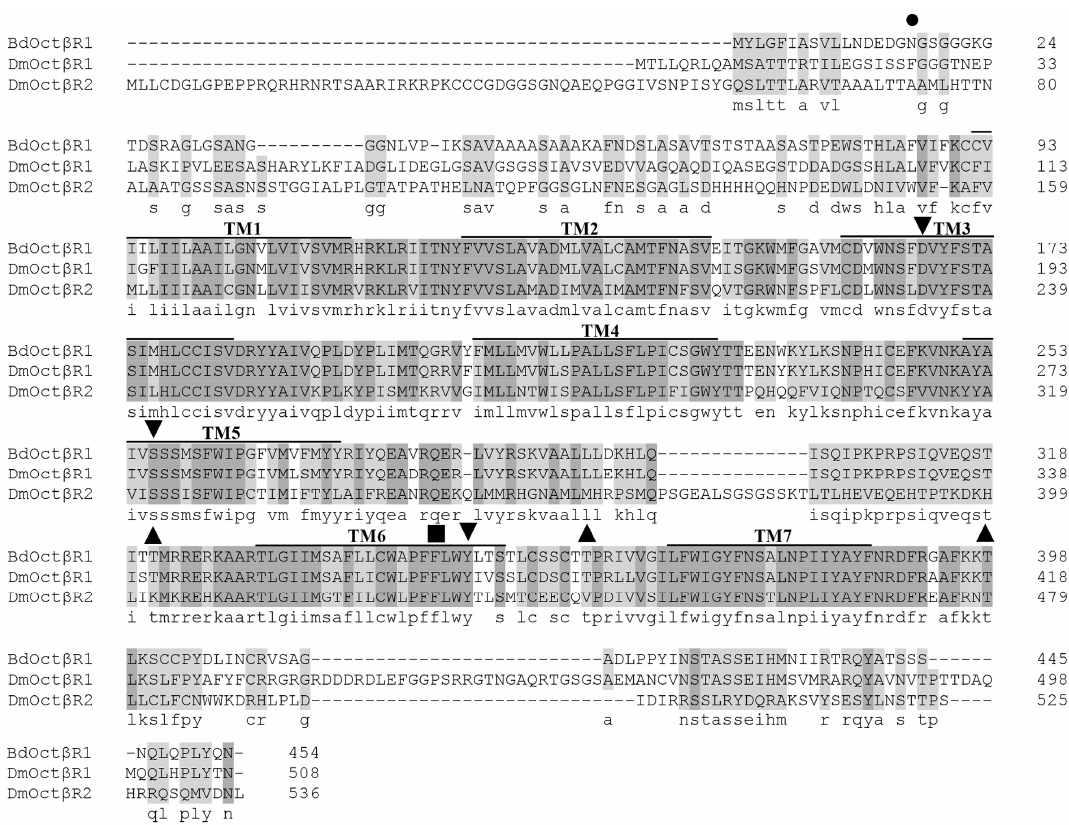
Figure 1. Amino acid sequence alignment of BdOct β R1 and two β -adrenergic-like receptors from Drosophila melanogaster ( DmOct β R1 and DmOct β R2 ). TM, transmembrane domains. The seven transmembrane domains are numbered as TM1–7. The shaded sequences highlight the identity level of amino acids between the receptors. Identical amino acids are highlighted in dark gray and conserved amino acids are on a light gray, as determined using the 50% majority rules. Dashes are gaps that were introduced for alignment. Potential phosphorylation sites for protein kinase C are labeled with ▲ and Potential N -glycosylation sites indicated by are ● . Amino acids which are labeled with ▼ are predicted to be involved in octopamine binding. The second phenylalanine after the FxxxWxP motif in TM6, which is a unique feature of aminergic receptors, is indicated by ■ .